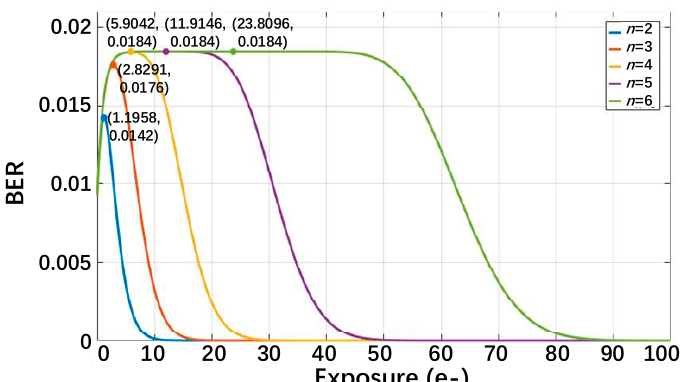
Figure 6. The BER as a function of the exposure H for different QIS bit depths for U n = 0.15e − and U thn = 0.15e − . The extreme points are marked.